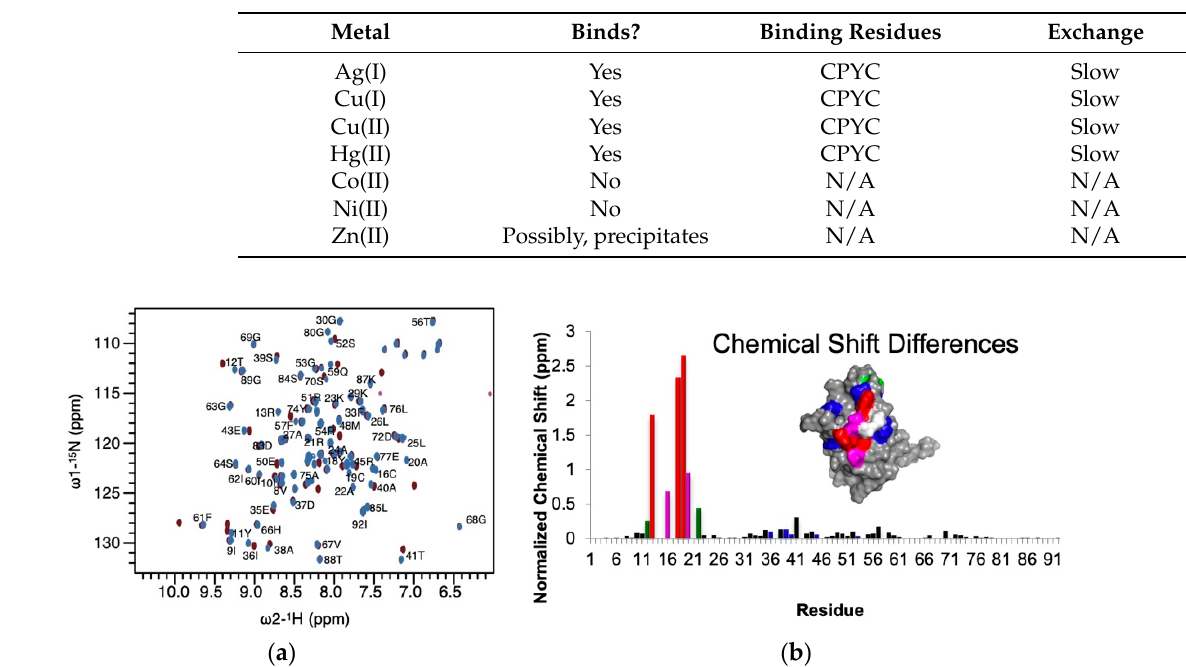
Figure 1. Chemical shift mapping of silver binding to GRX ( a ) HSQC of apo GRX (maroon) and 0.5 equivalents of silver (blue). ( b ) Normalized chemical shifts highlighted on the structure of silver metalated GRX (inset). Shifts > 1 ppm (red), 0.5 ppm (magenta), 0.25 (green), and 0.1 ppm (blue). Table 1. Metals tested for GRX binding.